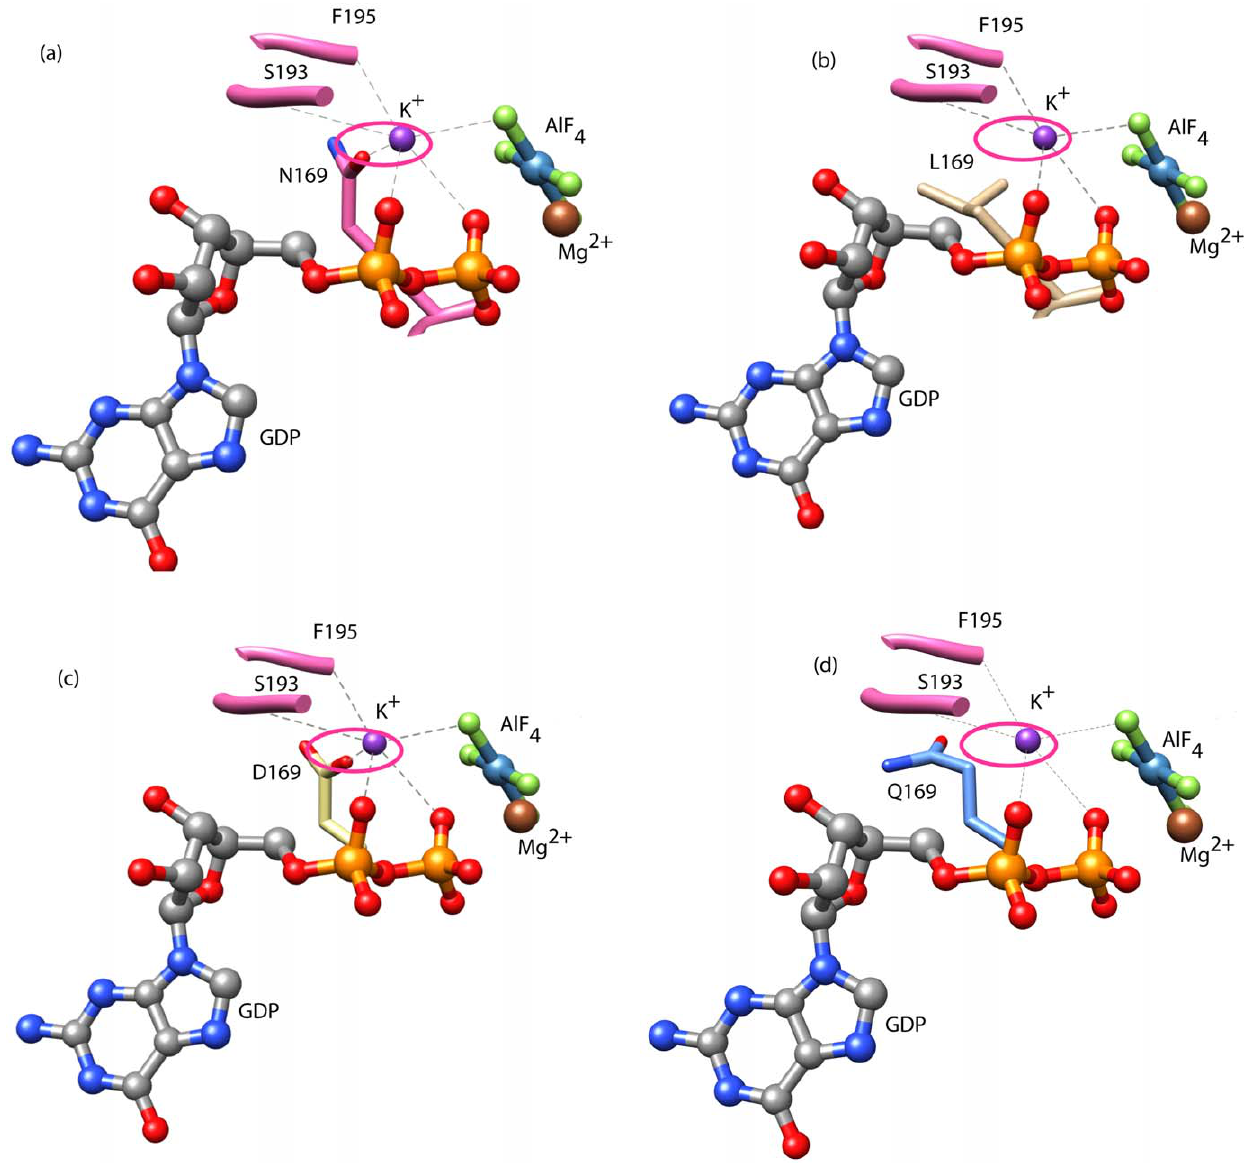
Figure 4. Hexa-coordinated potassium ion in the homology model of YqeH. GDP ? AlF x is shown in ball and stick model. The active site residues are displayed as sticks. Potassium is shown as a violet ball and its co-ordination with residues is indicated by dotted gray lines. Asn-169, one of the ligands coordinating potassium, is shown. Magnesium is shown as a brown ball. (a) YqeH model shows that potassium is held in place by coordination with a , b and c phosphates of GTP, main chain interaction from the K-loop residues, S193 and F195, and side chain interaction with the amide group of Asn-169. The interaction with Asn-169 is highlighted by the pink circle. (b) N169L mutant that lacks the side chain carbonyl oxygen leads to loss of interaction with potassium. (c) N169D that retains the carbonyl oxygen and therefore the potassium coordination (d) N169Q, which despite possessing the carbonyl oxygen lacks potassium coordination due to an increased side chain length. Figures were made using chimera[37].